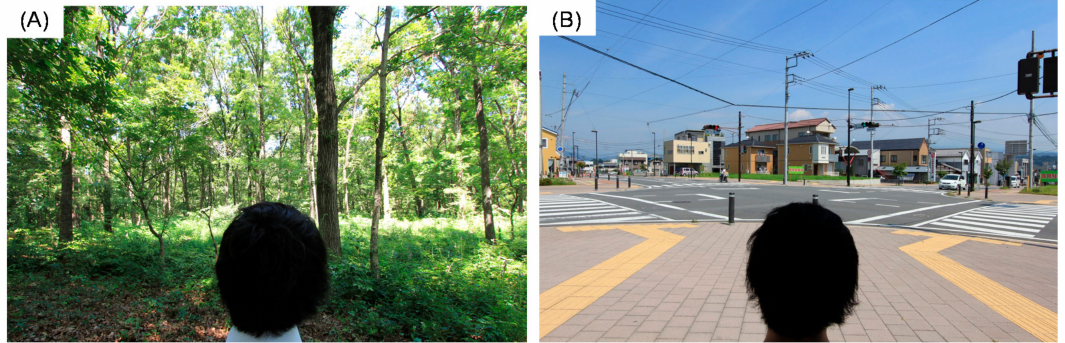
Figure 1. Experimental landscapes: ( A ) forested and ( B ) city